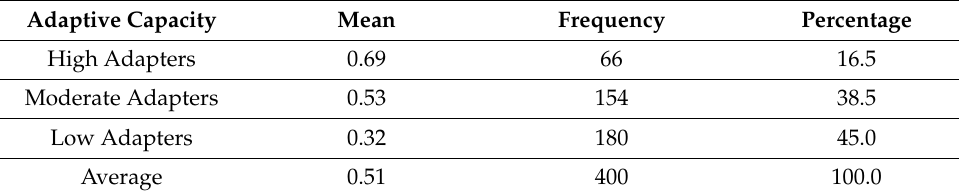
Table 6. Percentage of the degree of adaptive capacities of